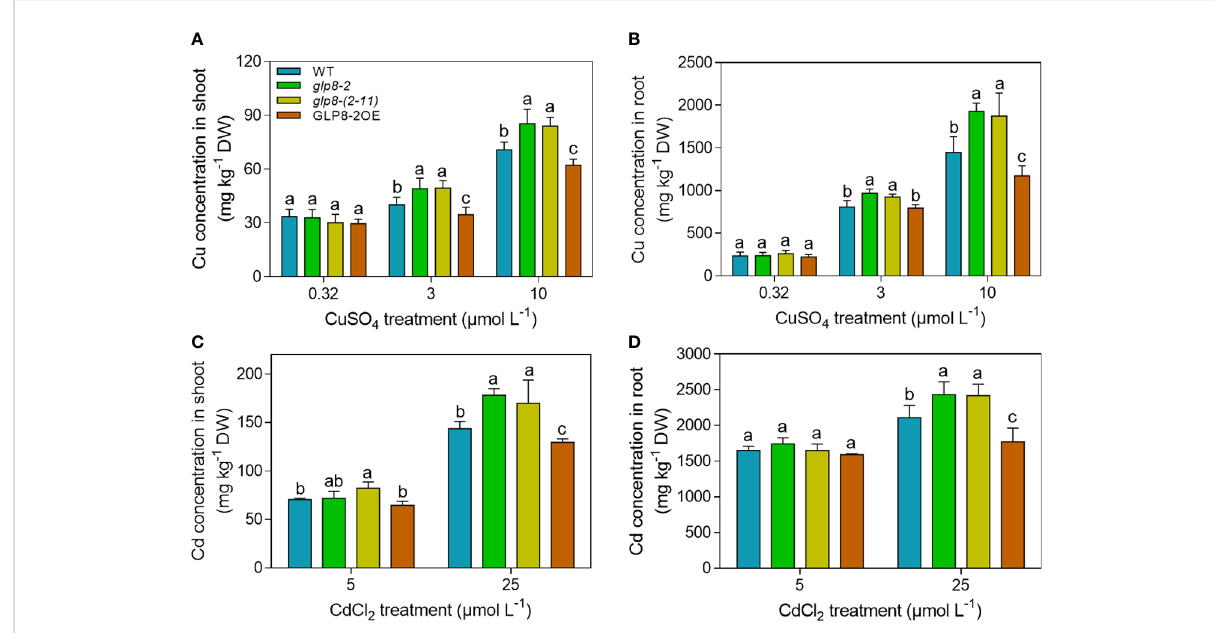
FIGURE 3 Knockout of OsGLPs affects heavy metal accumulation in rice. (A, B) Cu concentrations in the roots and shoots of two-week-old seedlings treated with 3 or 10 m mol L − 1 CuSO 4 for 5 days. (C, D) Cd concentrations in the roots and shoots of two-week-old seedlings treated with 5 or 25 m mol L − 1 CdCl 2 for 5 days. Values are the mean ± SD; n = 3. Different letters indicate a difference of p ≤ 0.05 by the LSD